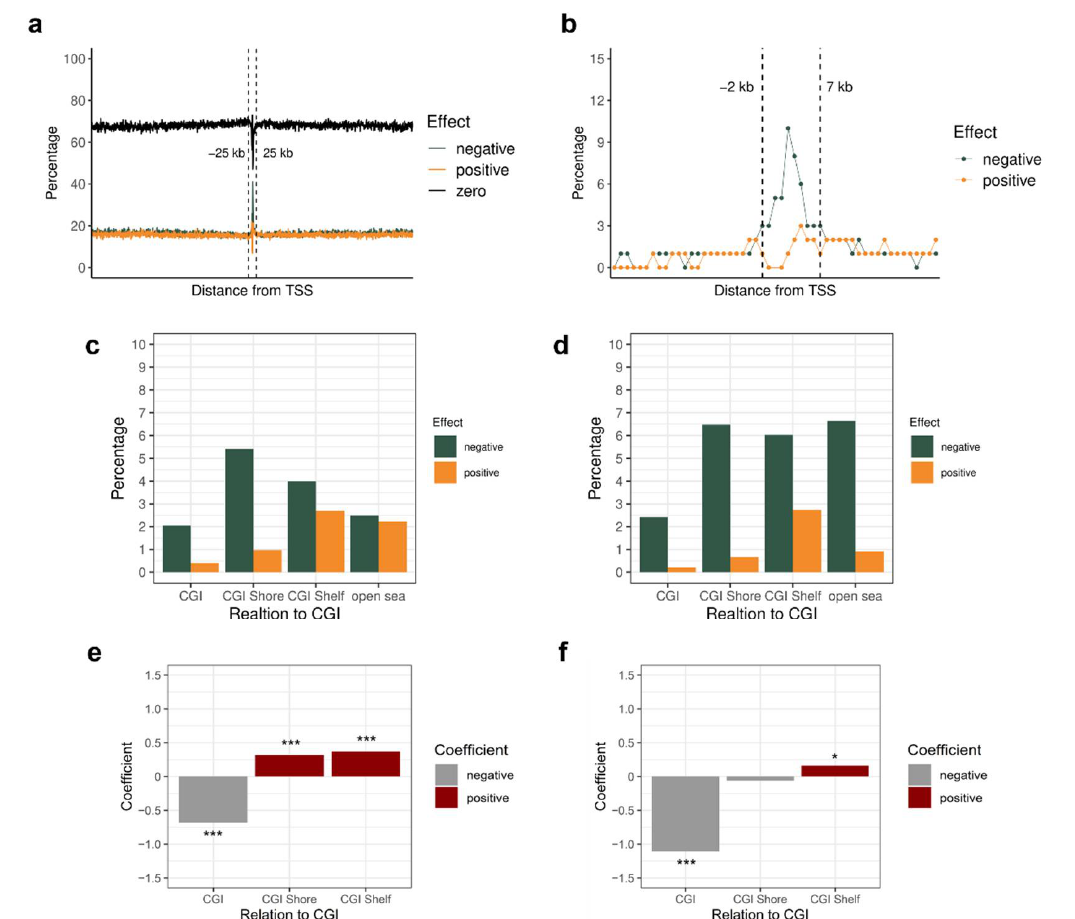
Figure 2. Regulatory effects represented by coefficients of CpG sites. Green, negative effect probes; orange, positive effect probes; black, zero, noneffective. ( a ) Effects of probes according to the distance from TSS. Probes within ±1 Mb of TSS were used. ( b – f ) The percentage of probes was represented by dividing the number of probes with absolute normalized coefficients of 1 by the number of probes with absolute coefficients more than zero. ( b ) Effects according to the distance from TSS. Only probes within ±25 kb were plotted. ( c ) Effects according to the relation to CGI within ±1 Mb of TSS. ( d ) Effects according to the relation to CGI within 2 kb upstream to 7 kb downstream of TSS. ( e , f ) Comparison of importance among CGI-related regions by logistic regression. The positive coefficient indicates a high probability of important probes in that region (red bar). On the other hand, a negative coefficient means that the probes in that region have less importance (grey bar). The open sea was not represented because the coefficient was not estimated from the logistic regression model. The region where its coefficient was estimated with a considerably low p value ( p < 2.2 × 10 −10 ) was marked as ***, and that estimated with p < 0.05 was marked as * above the bar. ( e ) Probes within ±1 Mb of TSS were used. ( f ) Probes within 2 kb upstream to 7 kb downstream of TSS were used.